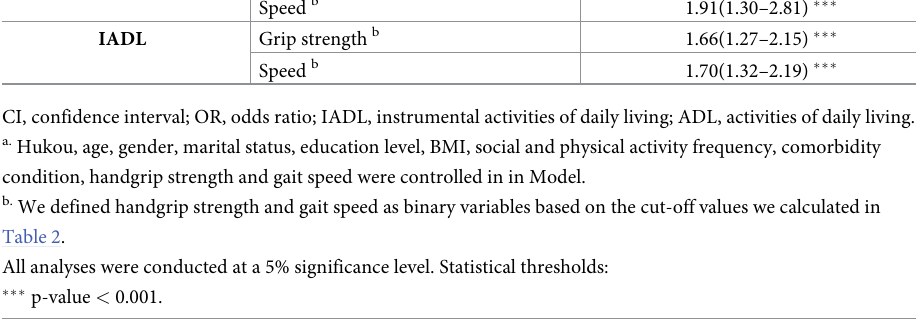
Table 3. Associations of physical performances with ADL and IADL disabilities in Chinese older adults (N = 6127). variables